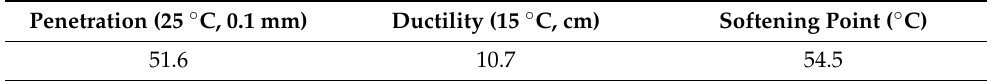
Table 6. Results of